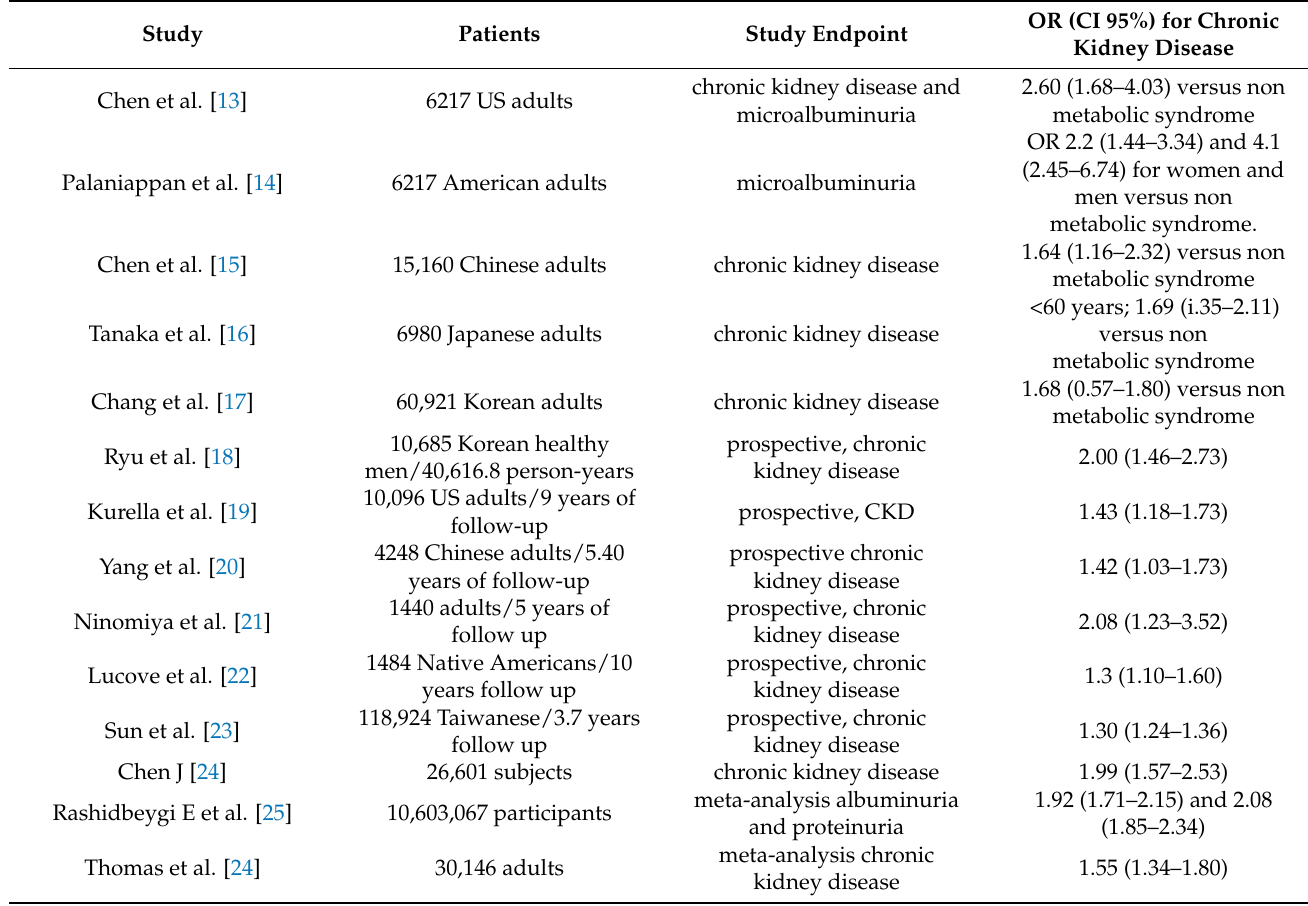
Table 1. Risk of CKD in adults with metabolic syndrome